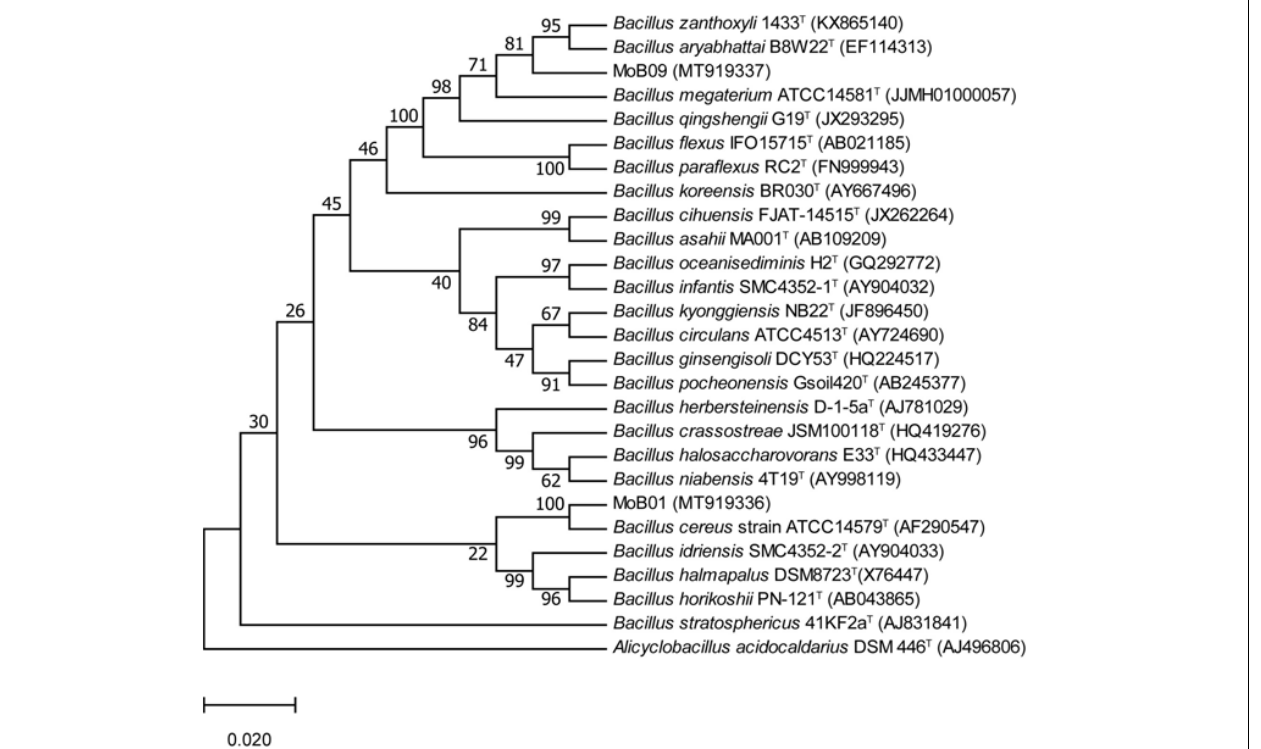
Frontiers in Microbiology |